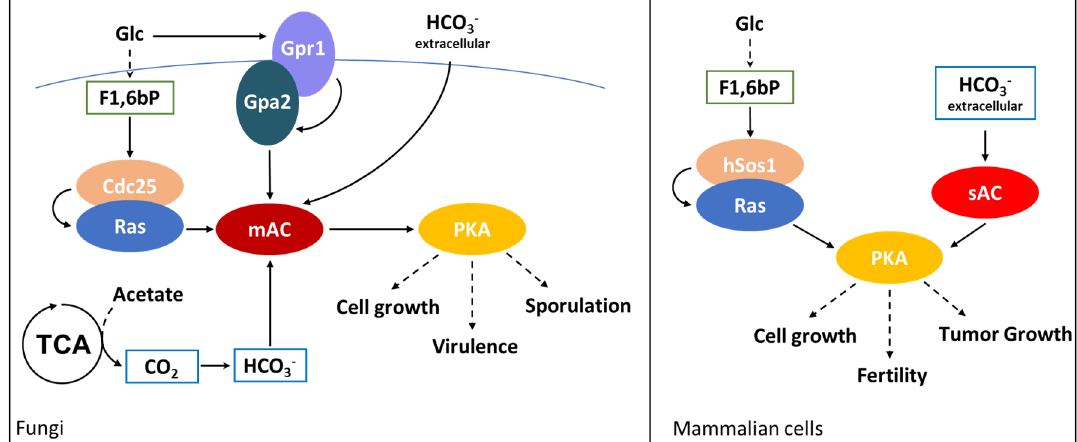
Figure 1. Ras / PKA modulation by PMIs. F1,6bP (green boxes) activates Ras both in yeasts and in mammals, interacting with Cdc25 and hSos1, respectively. Extracellular bicarbonate (blue boxes) interacts with yeast adenylate cyclase, activating virulence promoting processes, such as filamentous growth in C. albicans and encapsulation in C. neoformans . In mammalian cells, bicarbonate activates soluble adenylate cyclase (sAC) enabling the competence of spermatozoa. Moreover, this interaction promotes cellular growth in oncogenic Ras-driven tumors. In S. cerevisiae , acetate oxidation to CO 2 through the TCA cycle induces sporulation of diploid cells grown in medium containing only this carbon source. Continuous arrows indicate direct activations, dashed lines indicate indirect processes.